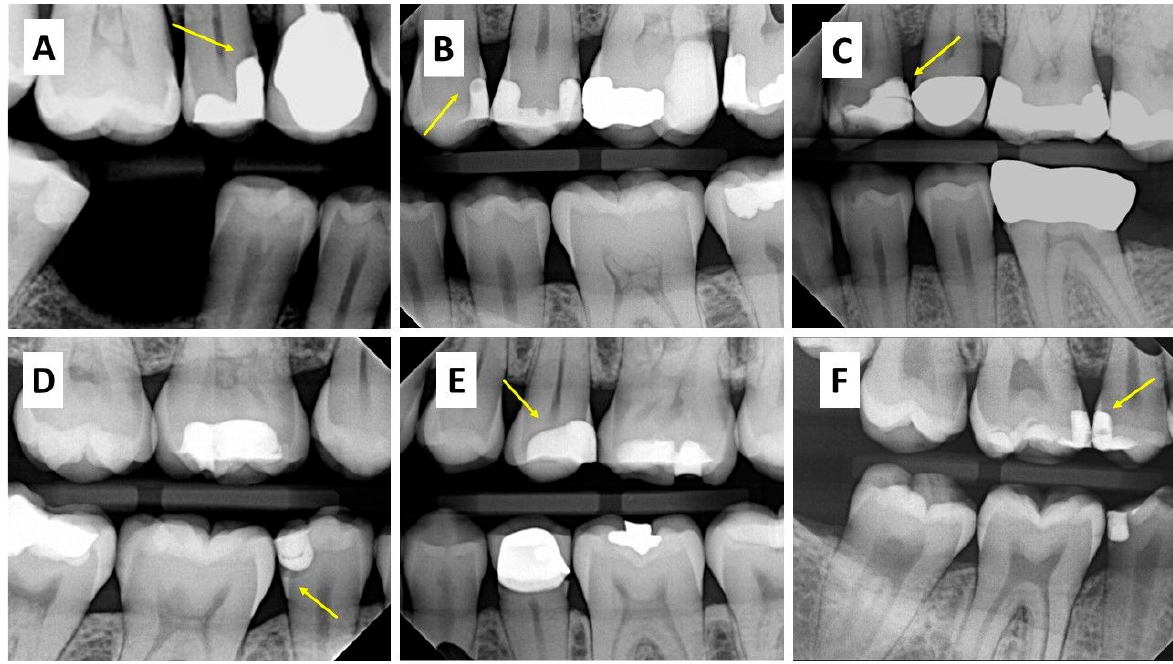
Figure 3. A panel of radiographic images illustrating some of the radiolucences found associated with Class II composite restorations (yellow arrows are highlighting the area of interests). ( A ) Secondary caries, ( B ) Voids in the body of the composite, ( C ) Interlayer lines within the body of composite, ( D ) External gap, ( E ) Internal gap, and ( F ) Combination of void in the composite and internal gap at the bonding interface.